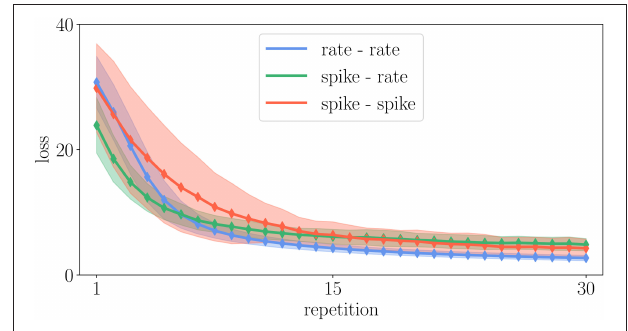
FIGURE 13 | Comparison of learning curves in the experiment described in Appendix Section 5.6 for different variants of the Urbanczik-Senn plasticity rule. The loss is averaged over 128 trials of different input patterns. Solid curves denote the mean value and the shaded area the corresponding standard deviation of the